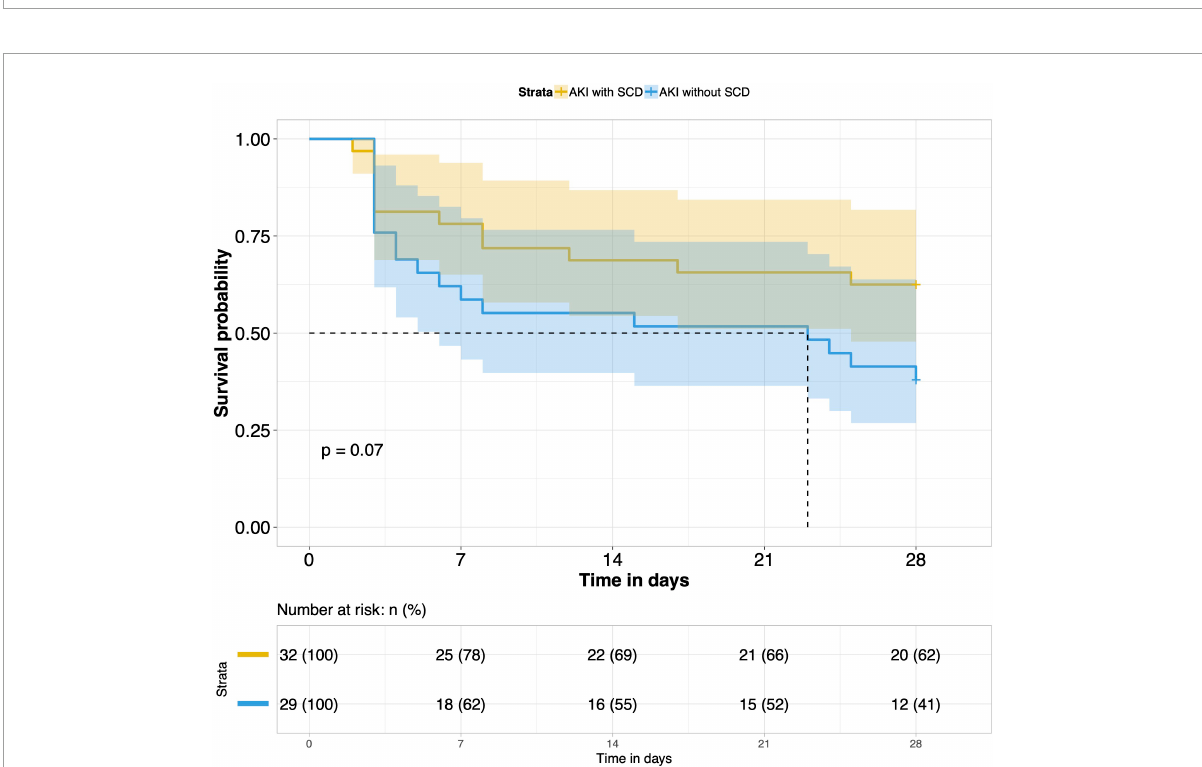
FIGURE7 Survival analysis of AKI with SCD group and AKI without SCD group (61 of 77 patients underwent bedside